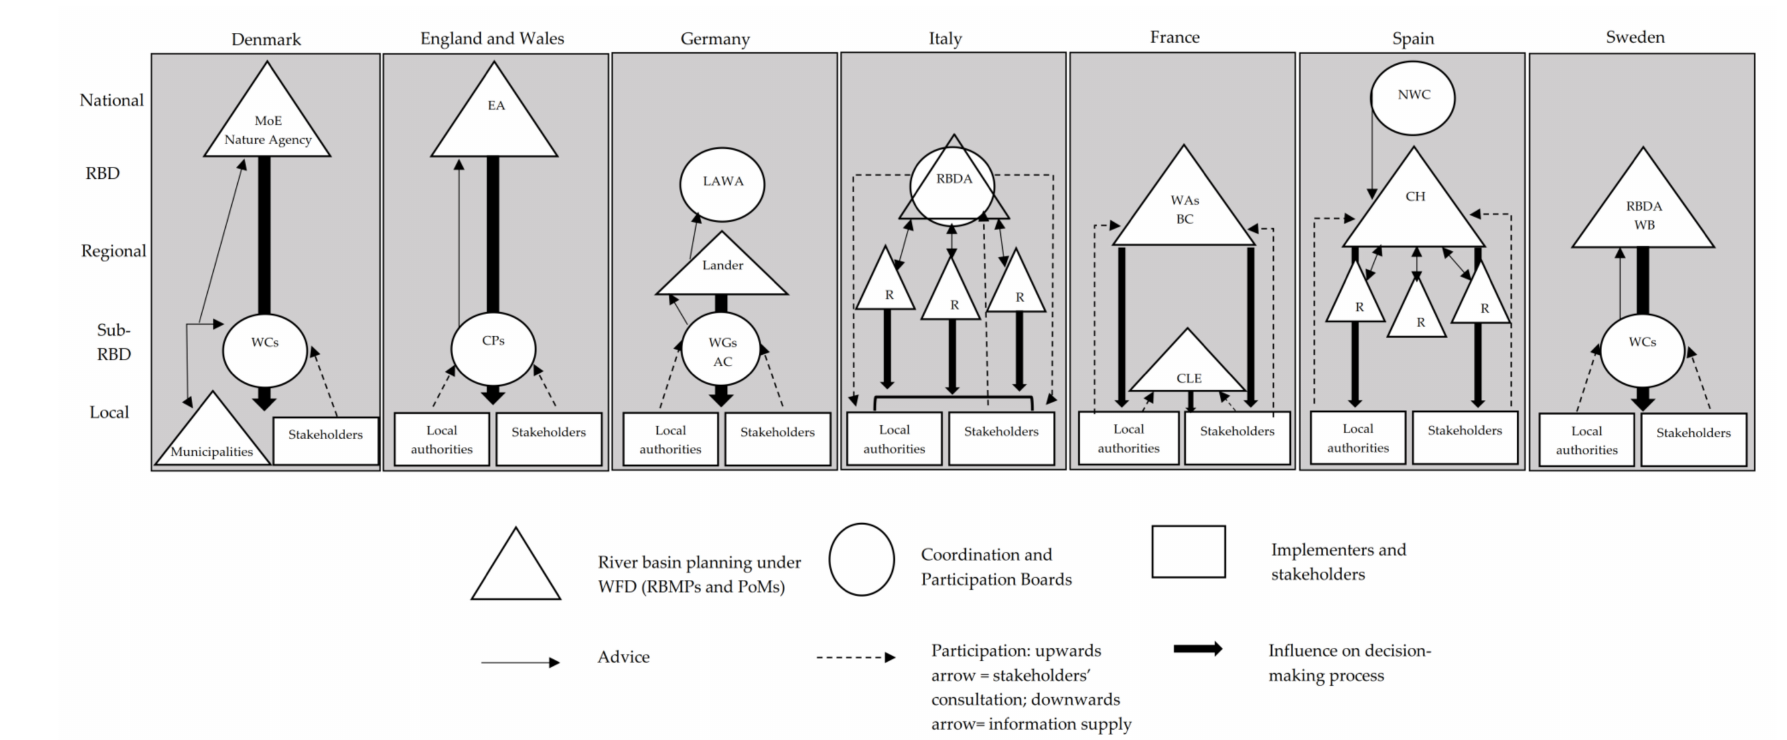
Figure 1. Governance structure for WFD implementation in the selected countries. Source: author’s own